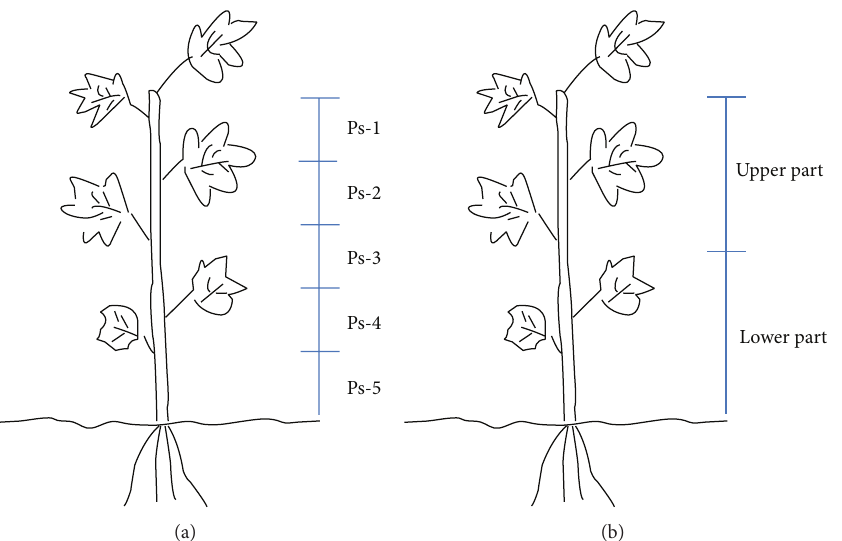
Figure 1: Sample collection fractions by plant section (a) and by upper and lower parts of plants (b).